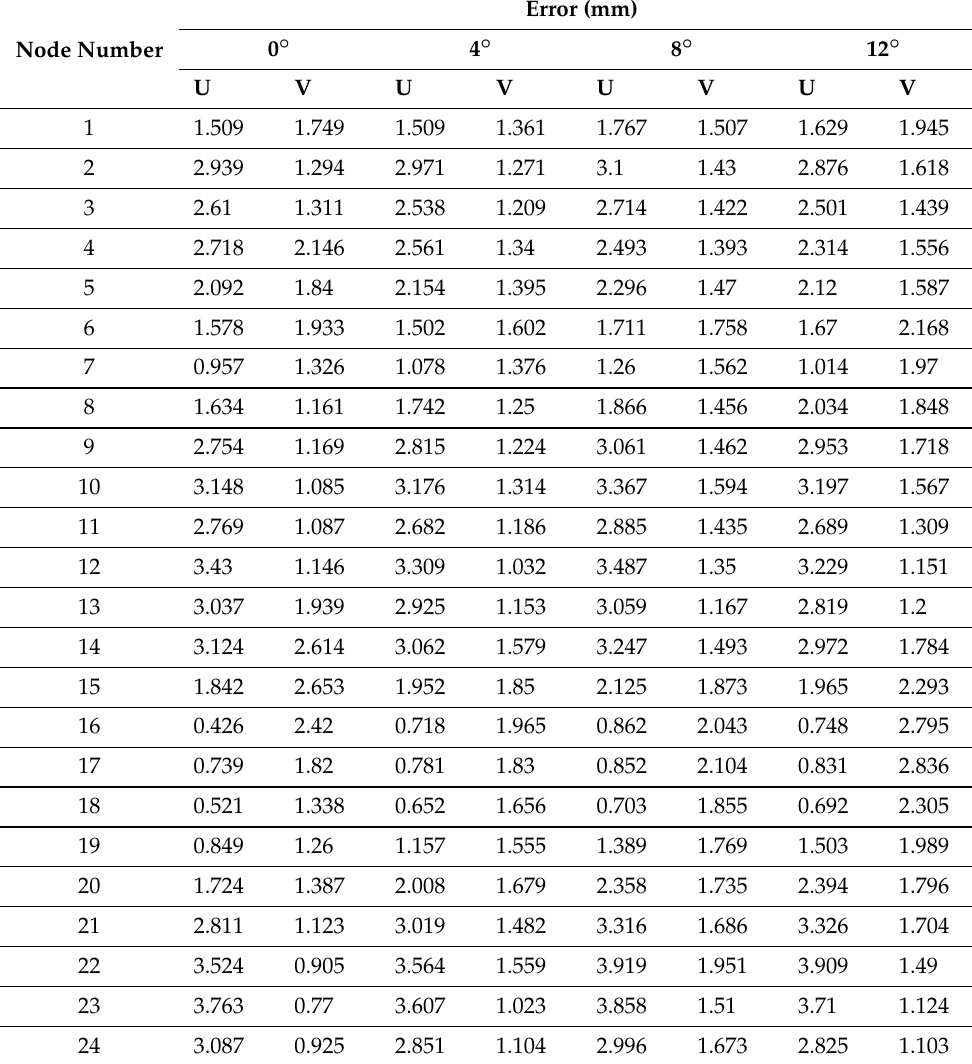
Table A1. Error between simulation and experiment for all the